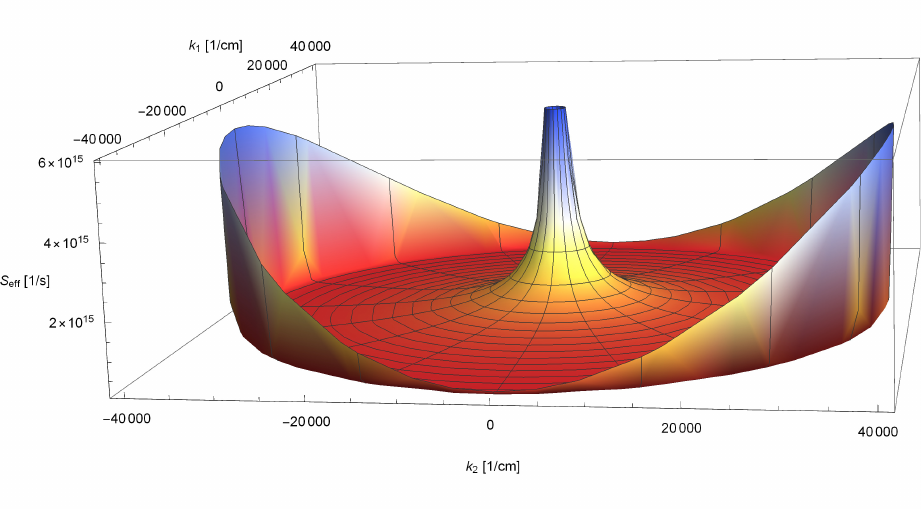
Figure 1. The spectral composition of the total photon production rate S γ ( k ) + S eh ( k ) in the long-wave region: the central 1/ k peak corresponds to the annihilation channel, the peripheral distribution represents the momentum redistribution